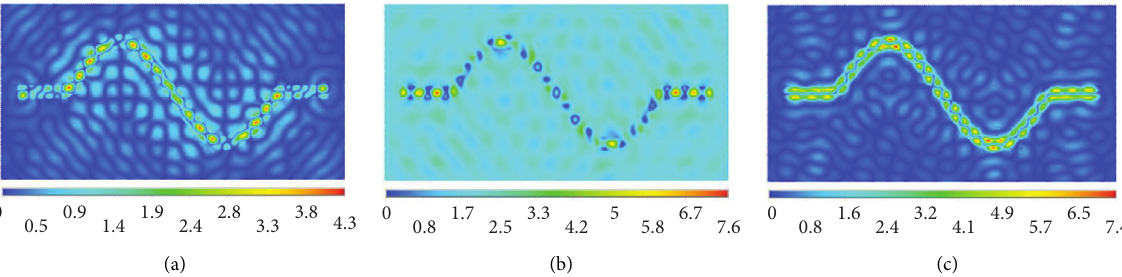
Figure 20: SH wave incident ( f � .3.0 Hz, H � 100m, C